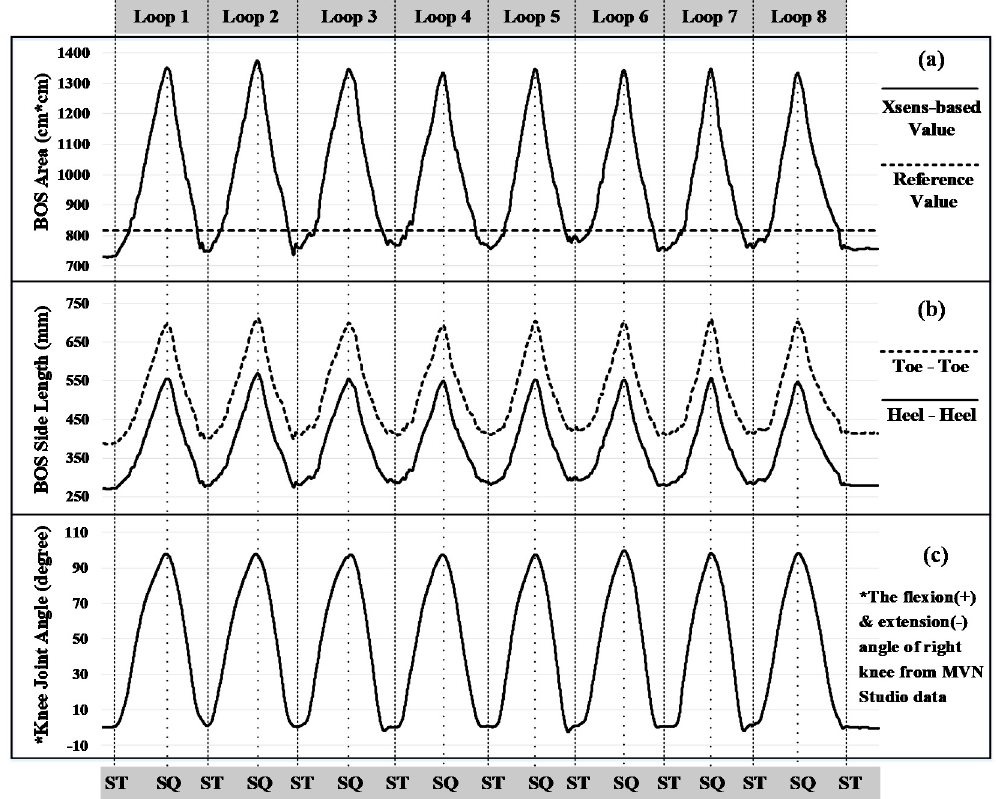
Figure 5. A typical example of the changes of ( a ) Xsens-based BOS area and ( b ) side lengths: Toe-Toe and Heel-Heel distances, along with ( c ) knee flexion/extension angle in a Standing-Full Squatting motion (Task 11). ST: Standing, SQ: